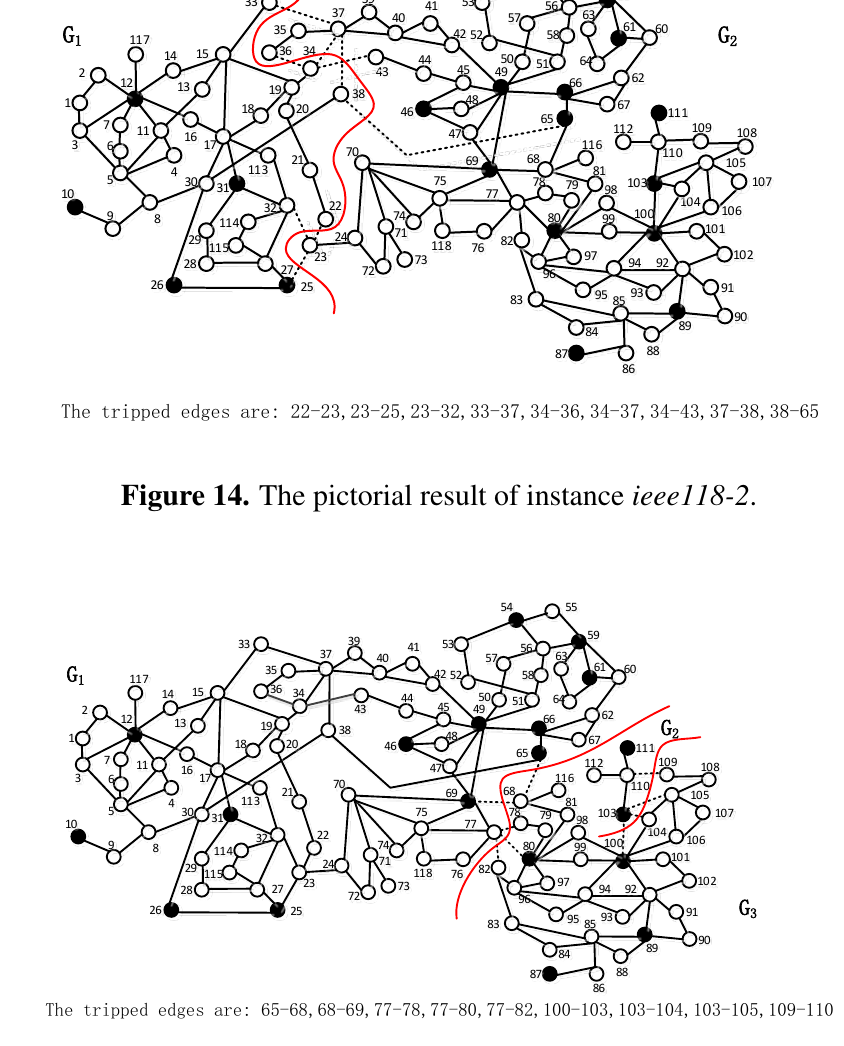
Figure 15. The pictorial result of instance ieee118-3-a